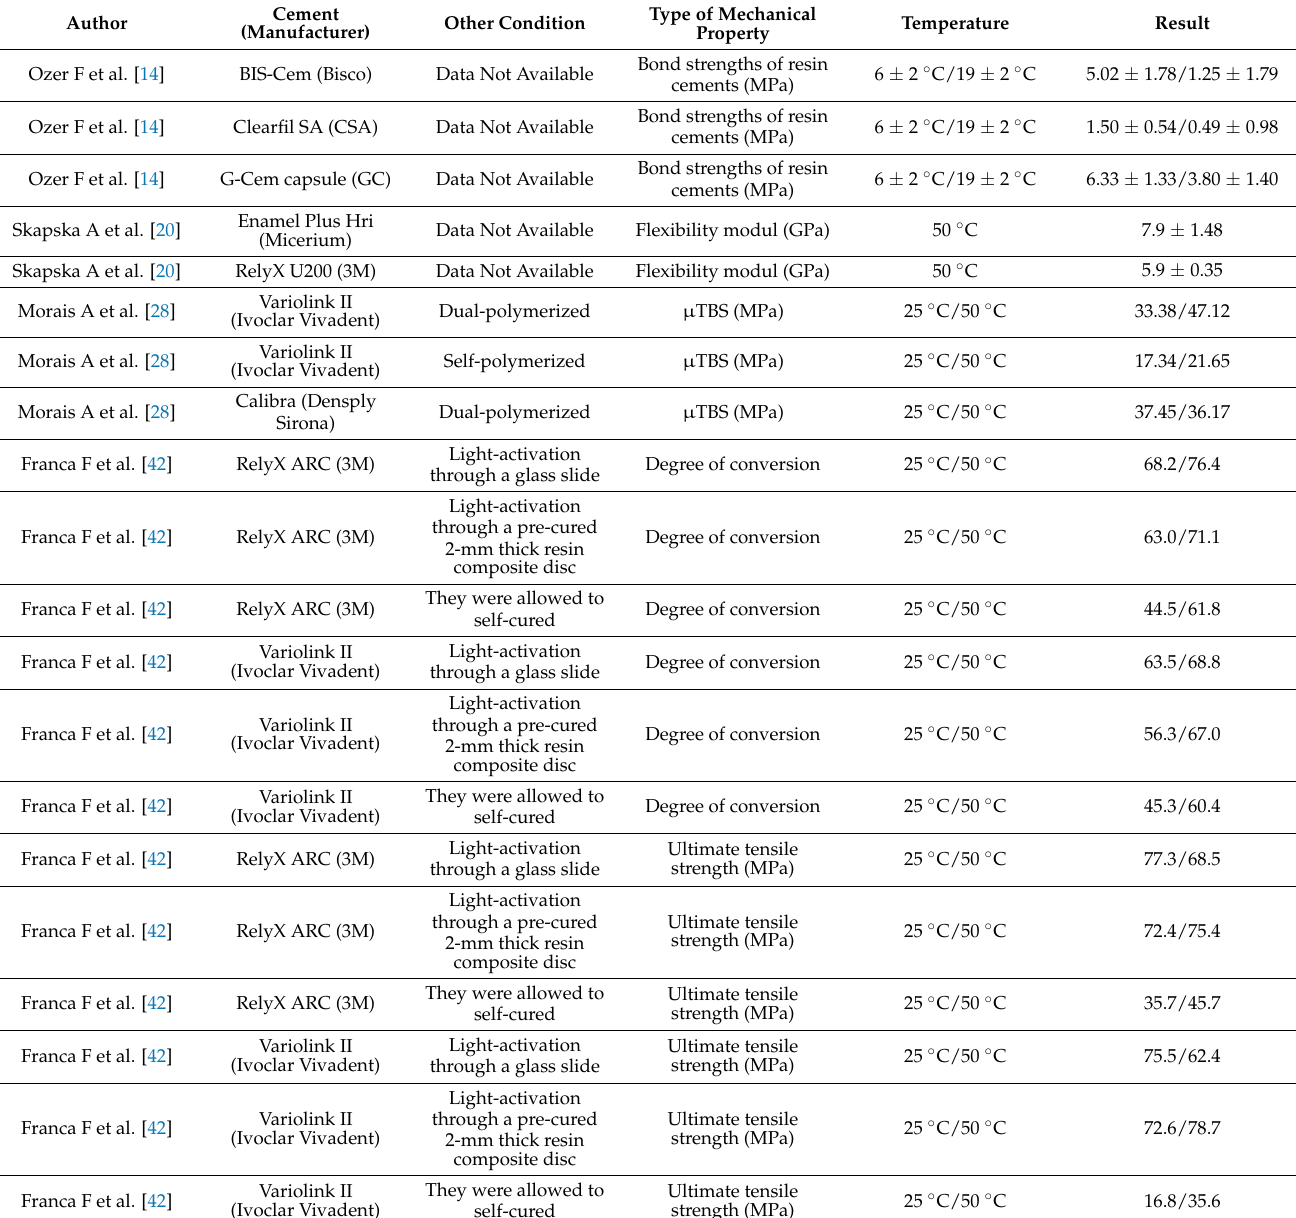
Table 4. Summary table of mechanical properties of materials relevant for this